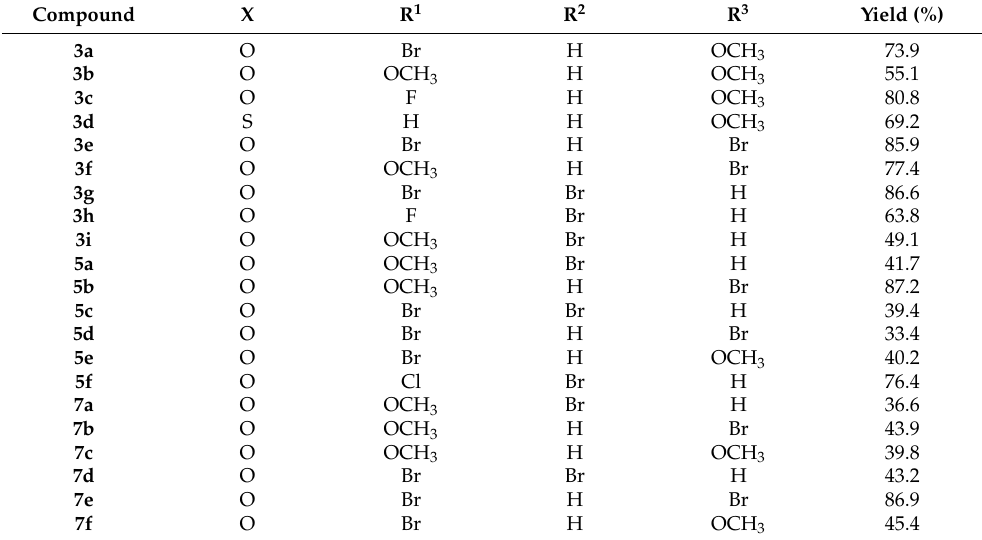
Figure 3. The reaction routes to compounds 3a – 3i , 5a – 5f , and 7a – 7f . Table 1. R-group of compounds 3a–3i , 5a–5f , and 7a–7f .